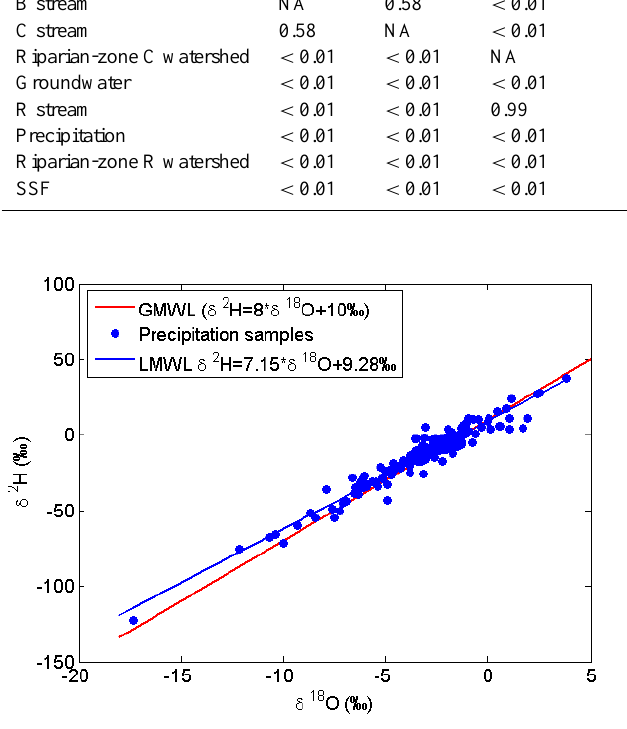
Figure 5. The Global Meteoric Water Line (GMWL) compared to the Local Meteoric Water Line (LMWL) of the study